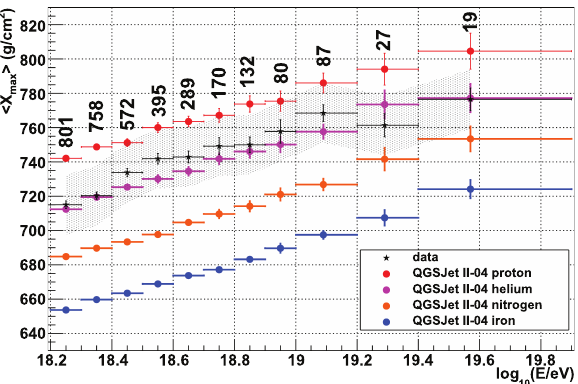
Figure14. Mean max asafunctionofenergyasobservedbyTAinBR LRhybridmodeover8.5yrofdatacollection.Thenumbersabovethedatapointsindicate the number of events observed. The gray band is the systematic uncertainty of this analysis. Reconstructed Monte Carlo data of four different primary species generatedusingtheQGSJetII-04hadronicmodelareshownforcomparison. Figure 3. Measurements of (cid:104) X pared to the predictions for pure beams of the hadronic model